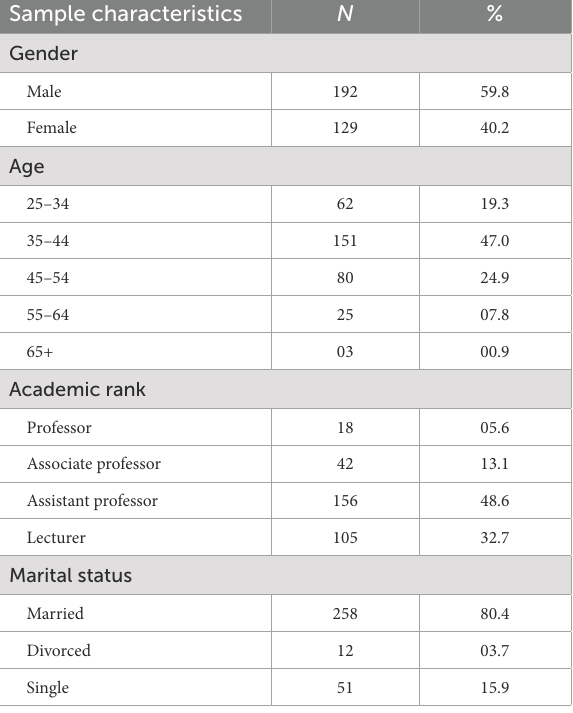
TABLE 1 Sociodemographic characteristics of the participants. Sample